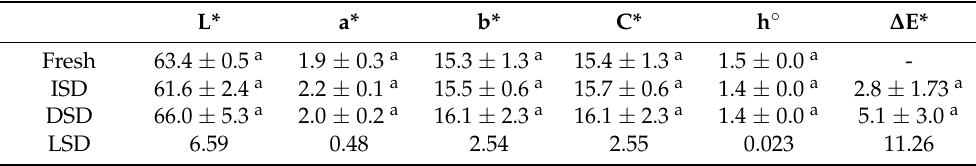
Table 2. Colour parameters of maize dried by ISD compared to DSD (means comparison t -test).